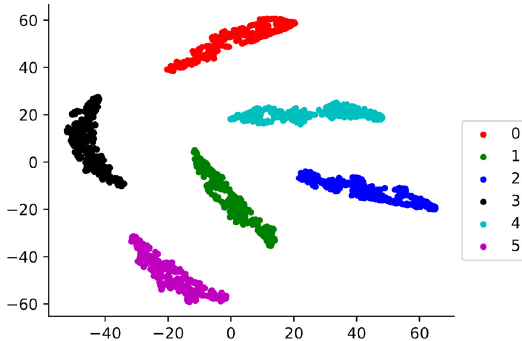
Figure 10. TSNE visualization results.